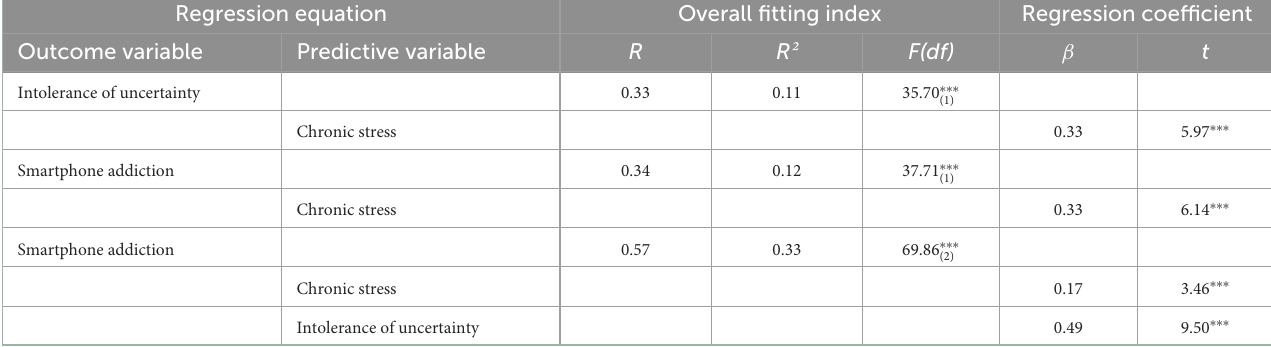
TABLE 2 Mediation analysis.